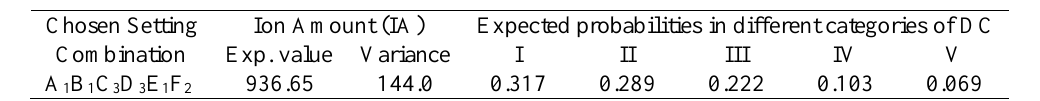
Table 6. Predicted values of interest for IA and different categories of DC at the chosen process condition. Chosen